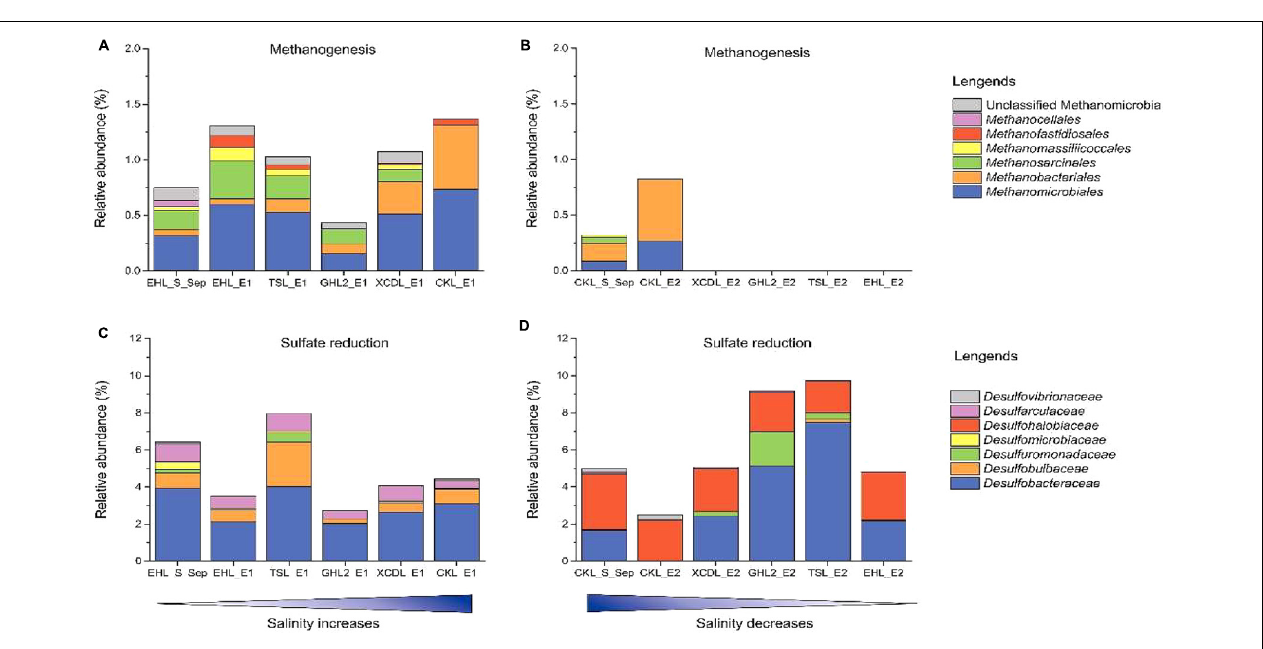
FIGURE 7 | Relative abundance of methanogen and sulfate reducing taxonomic groups after sediment transplantation. (A,C) In experiment 1 (simulating salinization). (B,D) in experiment 2 (simulating